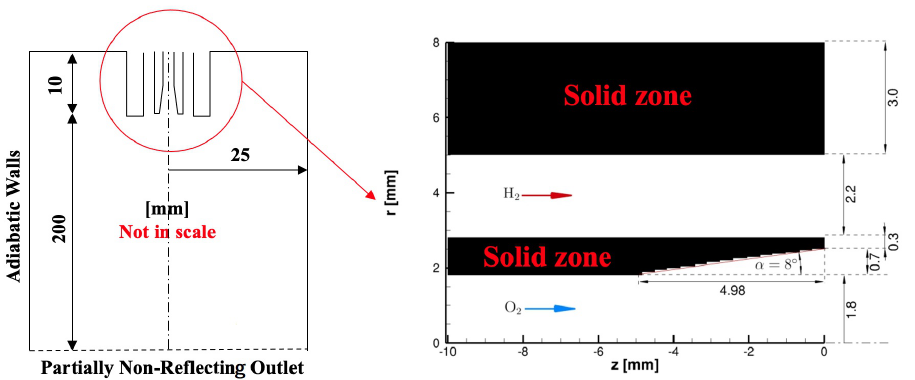
Figure 6. Sketch of the combustor and zoomed-in view of the tapered injector in the MASCOTTE C-60 test case, here modeled in a staircase fashion.